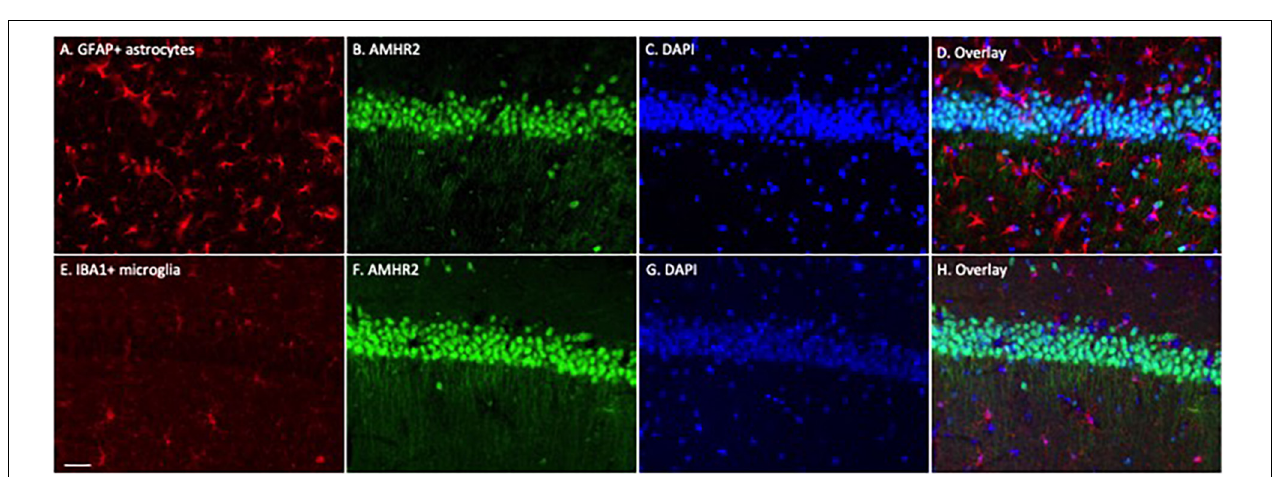
FIGURE 2 | Astrocytes and microglia in the mouse hippocampus do not express AMHR2. Representative coronal sections were fluorescent-labeled for glial fibrillary acidic protein (GFAP; red; A ), ionized calcium binding adaptor molecule 1 (IBA1; red; E ), AMHR2 (green; B,F ), and DAPI (nuclear staining; blue; C,G ). AMHR2 protein is not co-localized with GFAP (D) or IBA1 (H) . Scale bar = 40 µ m.